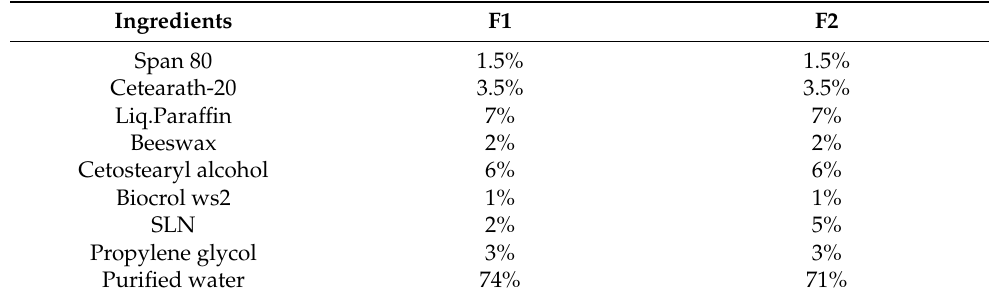
Table 1. Formulation of PPEE-SLNs cream.